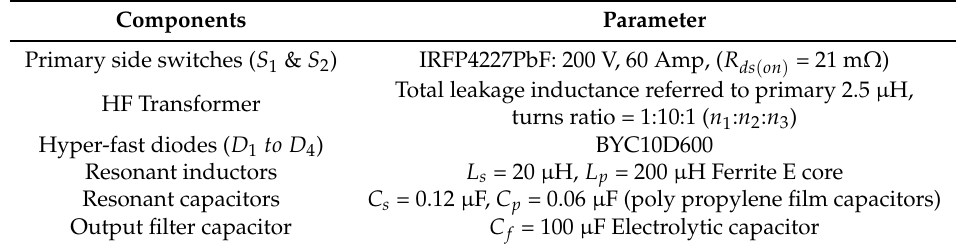
Table 1. Component Parameters of experimental Prototype.